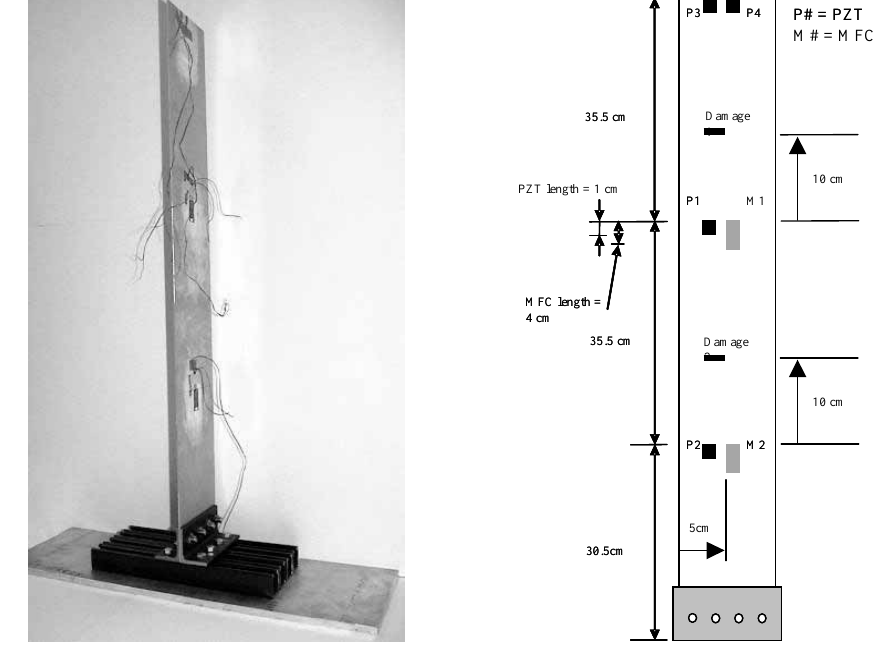
Fig. 7. Cantilevered Aluminum Plate. PZT and MFC patches are mounted at 3